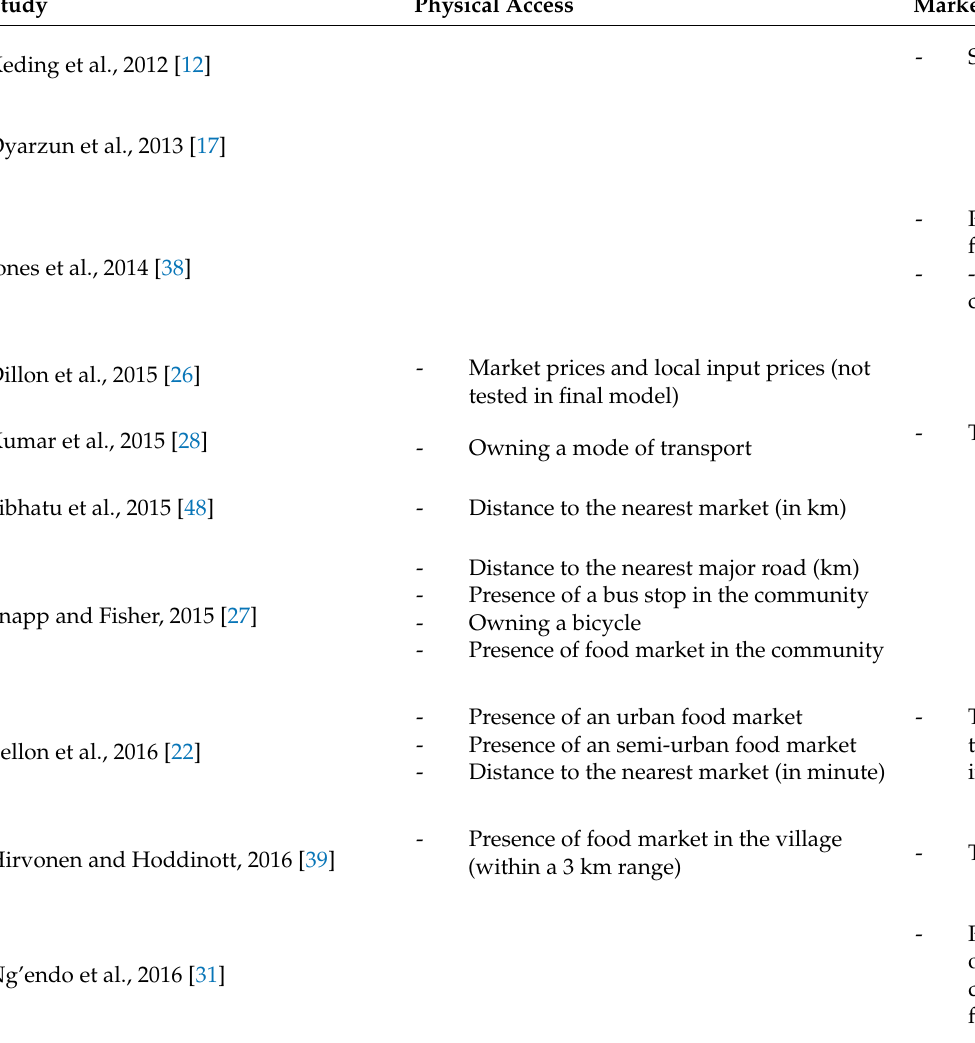
Table A2. Indicators Used to Measure Market Access and/or Market Participation ( n =